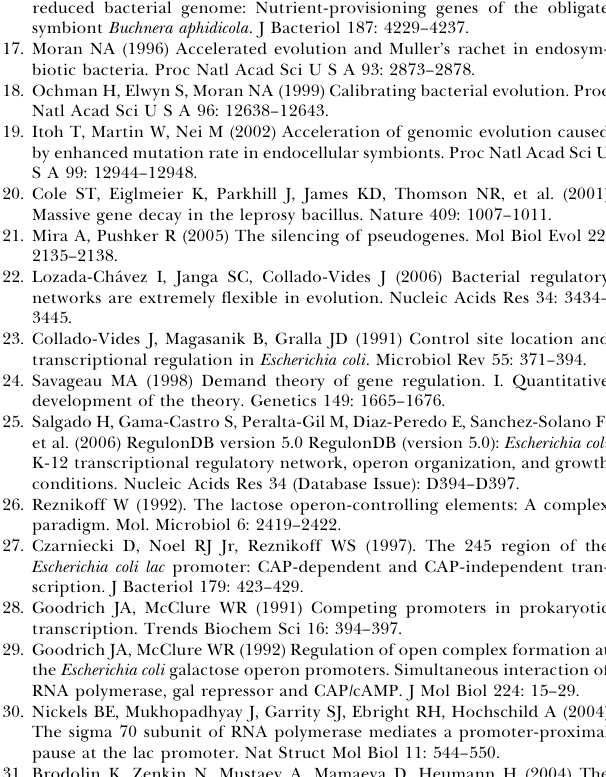
Figure S1. Signal Density in Regulatory versus Nonregulatory Regions for All Analyzed Eubacterial Genomes Found at doi:10.1371/journal.pgen.0020185.sg001 (5.4 MB PDF).